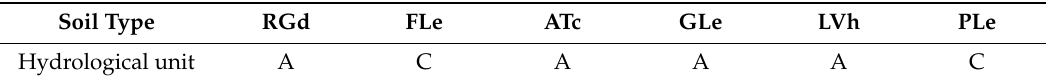
Table 2. Soil types and the corresponding hydrological unit in the study area.